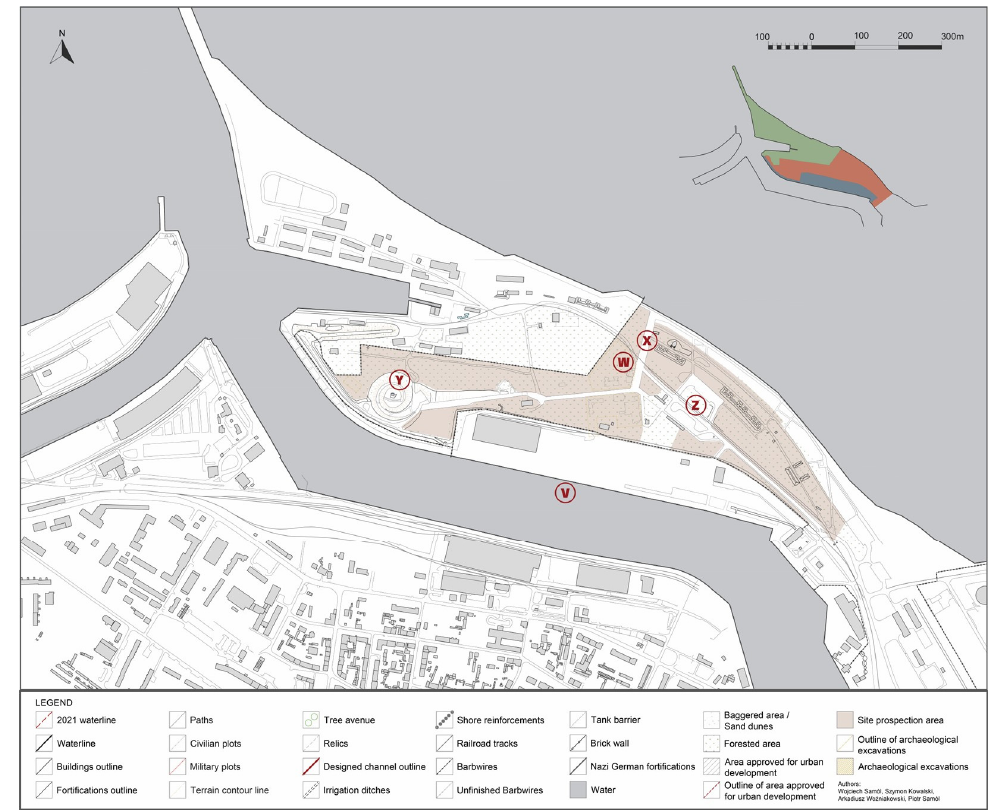
Figure 12. Modern-day Westerplatte with a monumental statue on the mound, container terminal and military area. The map also includes a prospection of the terrain and archaeological excavations. The top scheme shows the division problem—today’s Westerplattehas three different land users. Green—Army, red—memorial site, blue—container terminal.